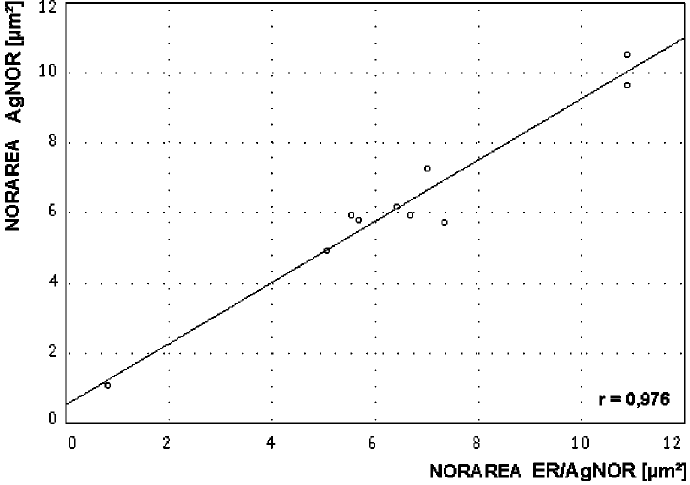
Fig. 3. Correlation of the total AgNOR area per nucleus in single AgNOR stained cells (NORAREA AgNOR) and ER/AgNOR stained cells (NORAREA ER/AgNOR). The circles represent 10 invasive ductal breast cancers (5 ER-positive and 5 ER-negative